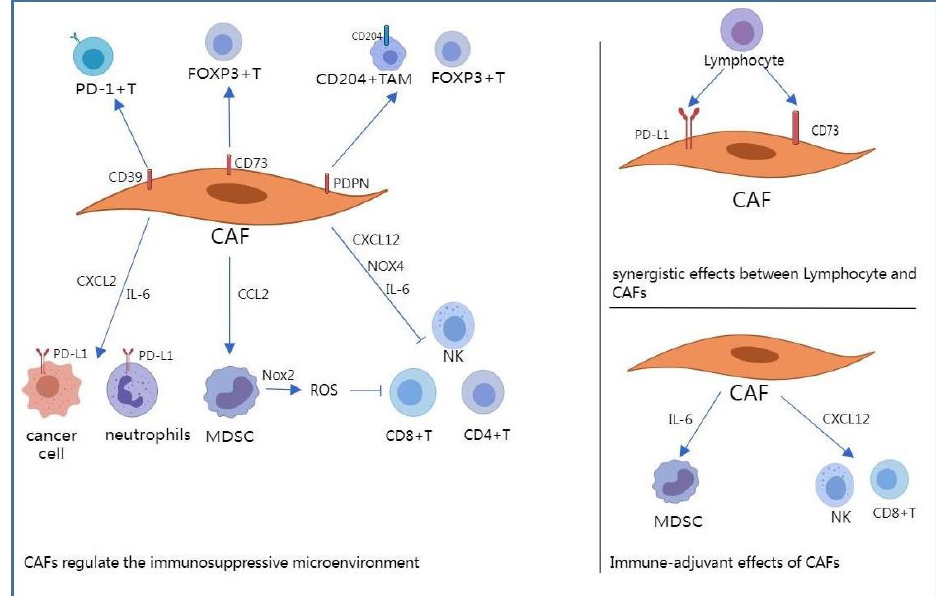
Figure 2. Cancer-associated fibroblasts (CAFs) regulate the immune microenvironment of NSCLC mediate NSCLC. MDSC, myeloid-derived suppressor cell; NK, natural killer cell; TAM, tumor-associated macrophages .